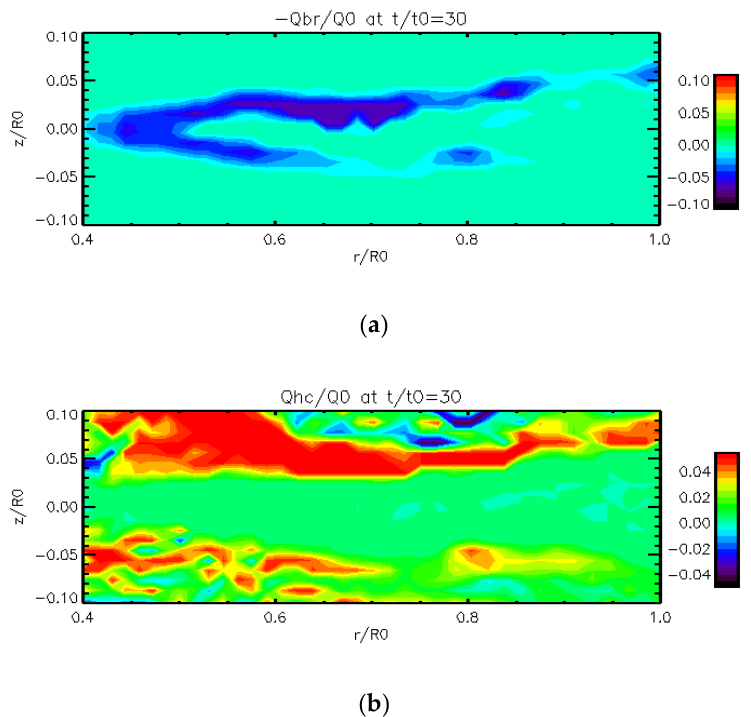
denote same meaning as ( a ).